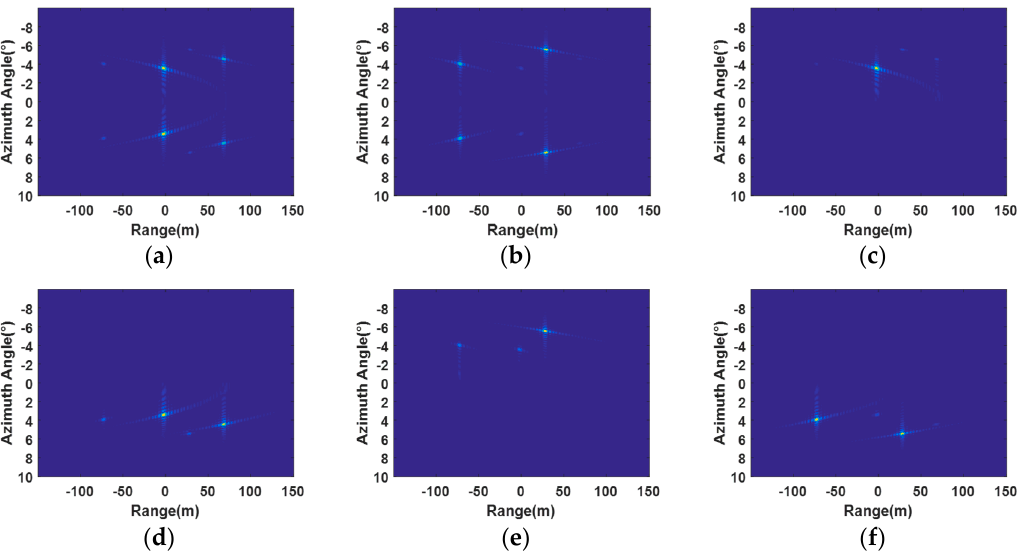
Figure 8. Imaging results of the forward-looking FDA-SAR. ( a ) Imaging of the first range region by BP. ( b ) Imaging of the second range region by BP. ( c ) Left side of the first region after receive beamforming. ( d ) Right side of the first region after receive beamforming. ( e ) Left side of the second range region after receive beamforming. ( f ) Right side of the second range region after receive beamforming.